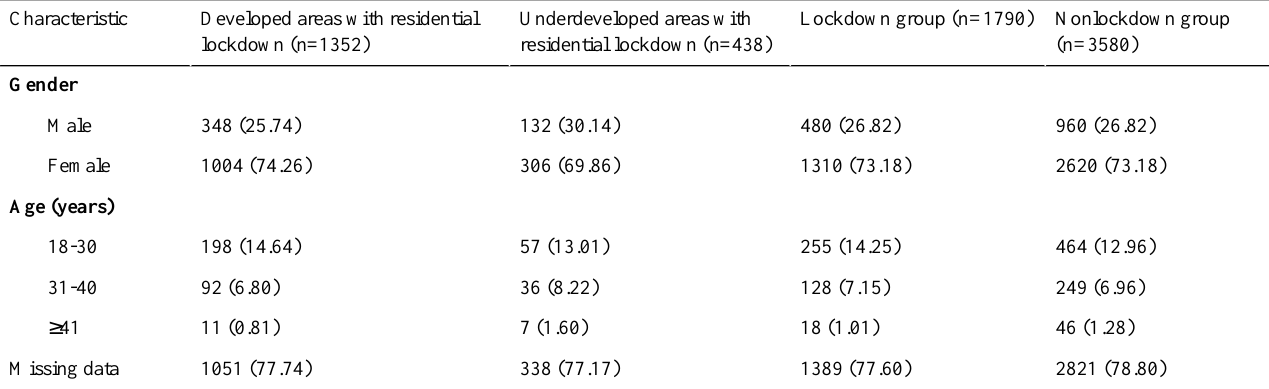
Table 4. Demographic characteristics of users in the lockdown group and nonlockdown group (N=5370), n (%).